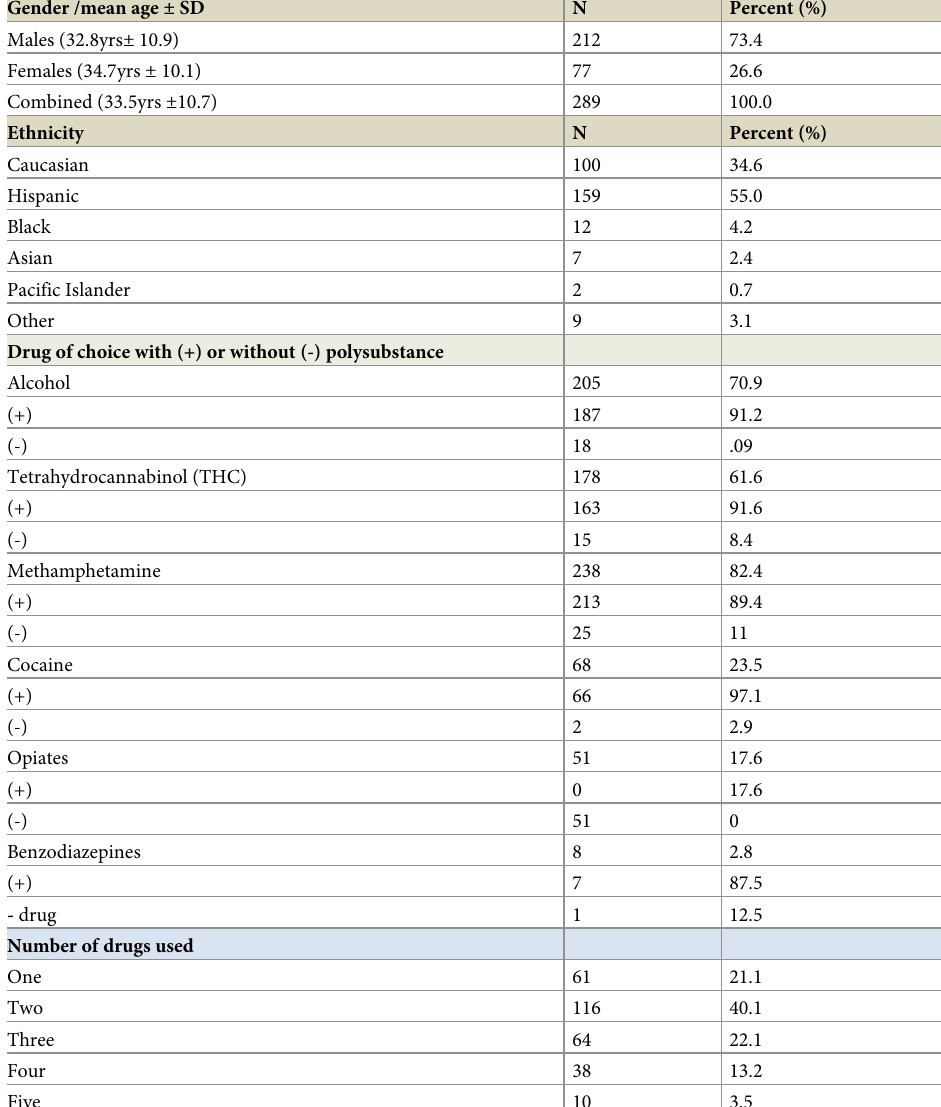
Table 1. Demographic and substance use